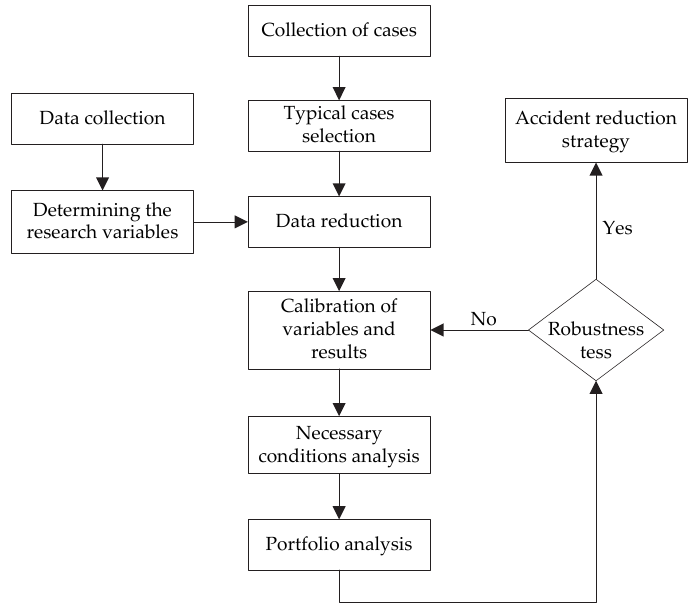
Figure 1. Flowchart of Research Methodology.